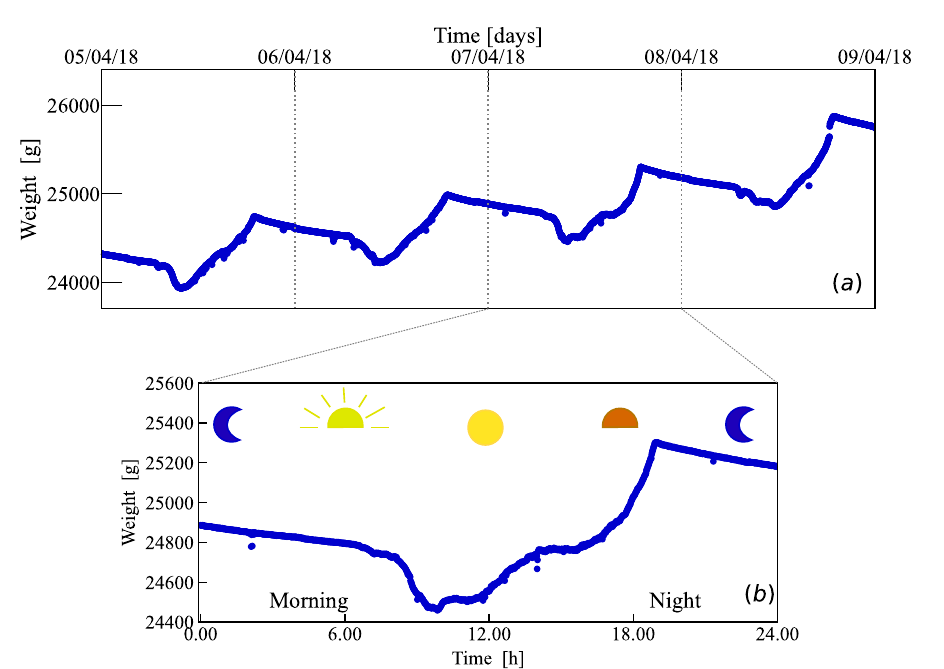
Fig 1. (a) The weight of a bee hive shows systematic variations throughout a day. The blue dots show the weight of a hive measured every minute for four consecutive days. (b) Each daily hive weight’s curve present consistent patterns at specific time ranges of morning, afternoon, evening and night